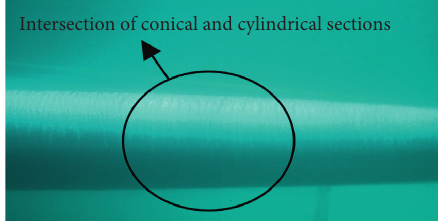
Figure 20: Single-frame photograph of supercavity